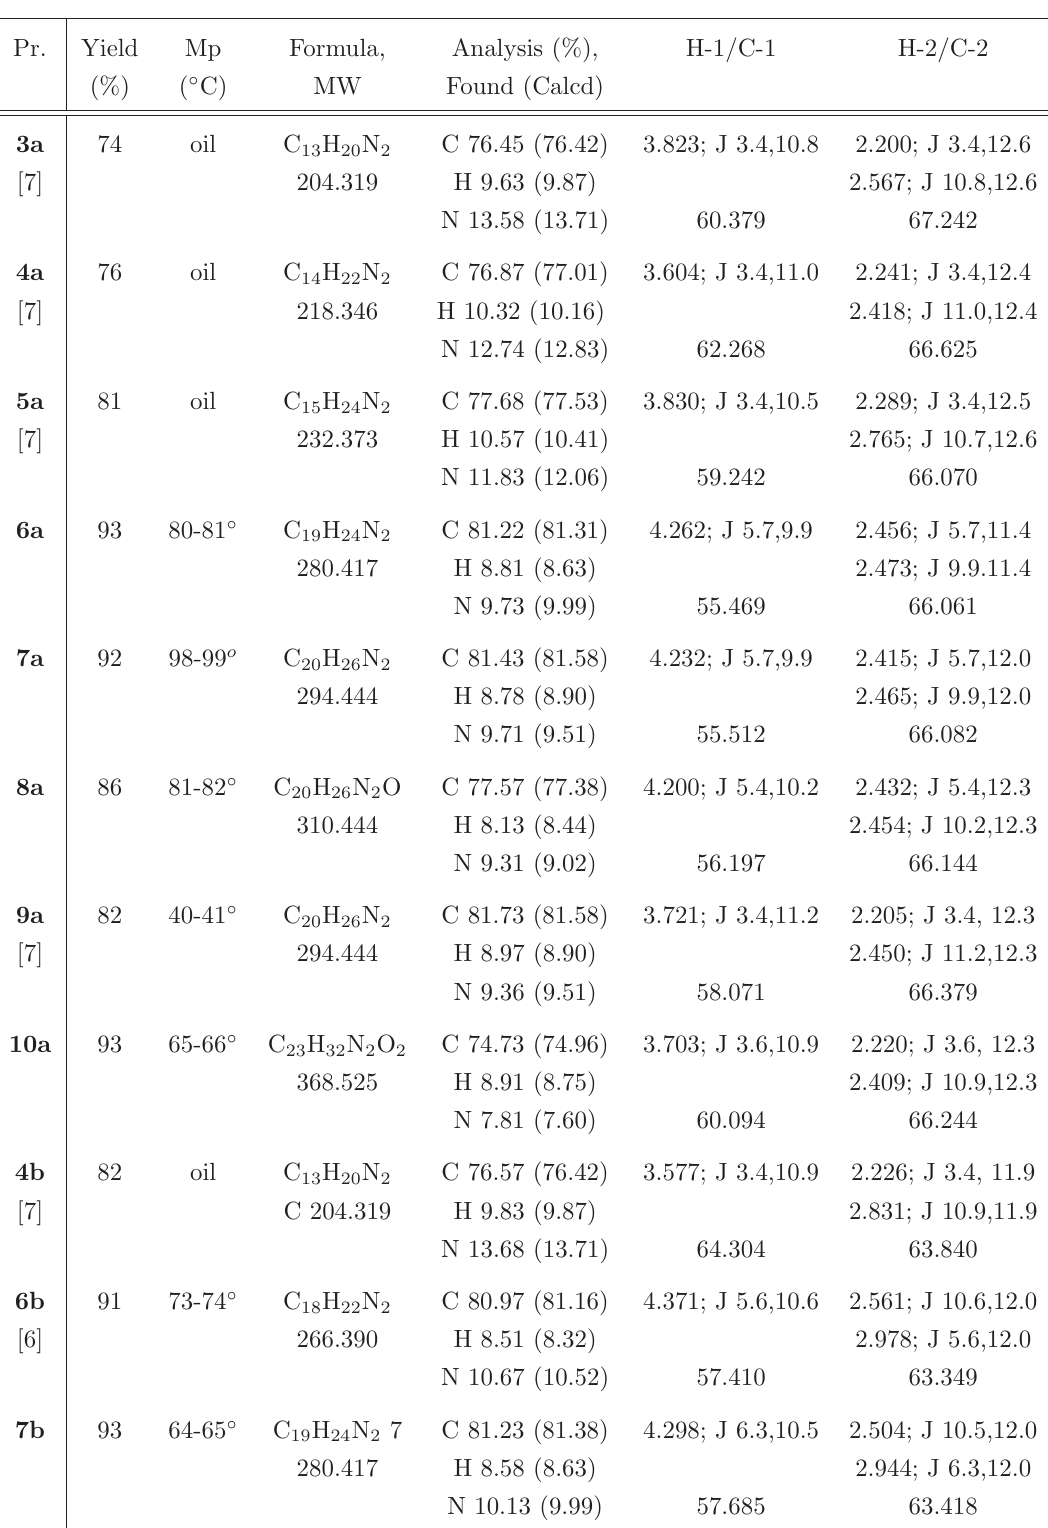
Table 2 Analytical and NMR data (CDCl 3 , δ referenced to TMS as an internal standard, J in Hz) of the skeleton nuclei of diamines 3 – 10